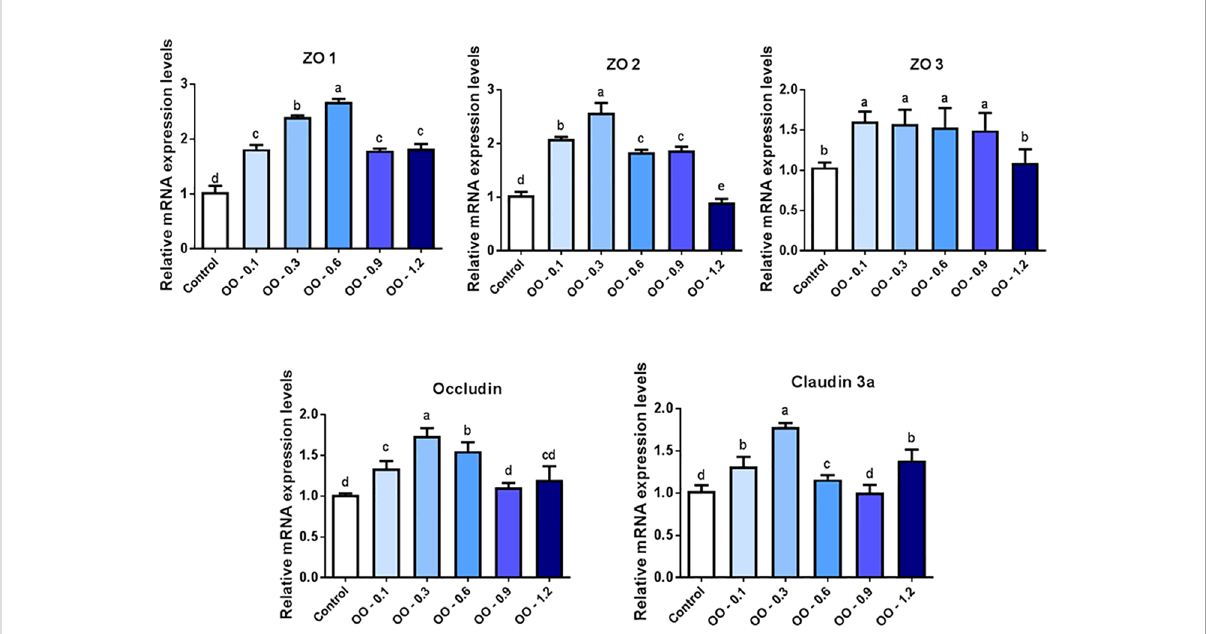
FIGURE 5 Effect of dietary oregano oil (OO) on the relative expression of tight junction-associated protein genes in the intestine of hybrid grouper. Different lowercase letters show signi fi cant differences among treatments by Tukey ’ s test (P <